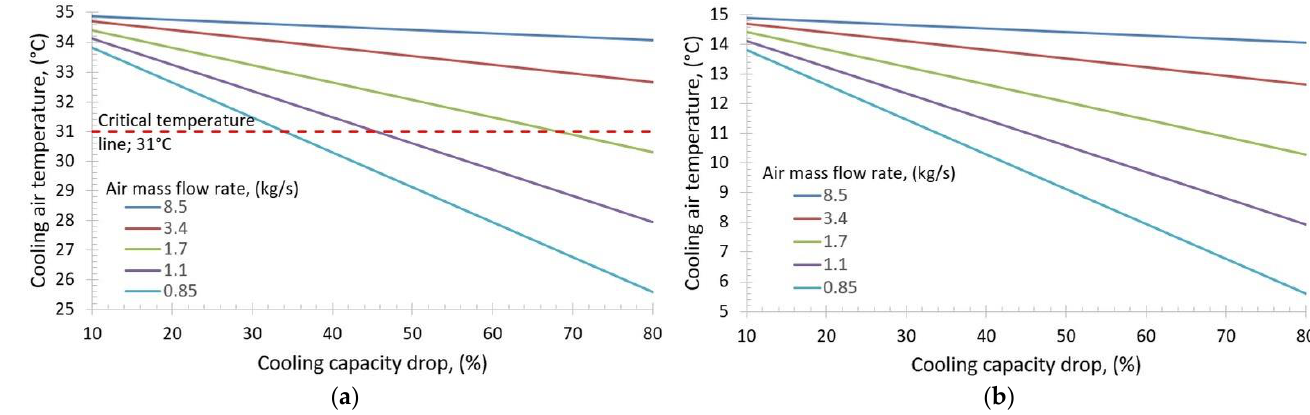
Figure 6. Cooling air temperature in the function of cooling capacity drop for different air mass flow rates in: ( a ) Supercritical cycle; ( b ) Subcritical cycle.